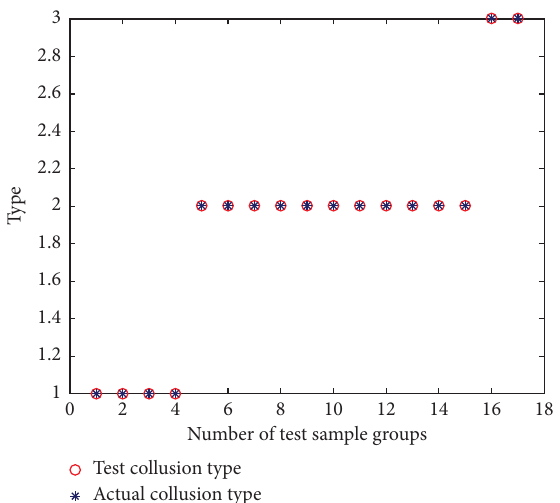
Figure 9: Classification of predicted collusion categories and actual collusion categories.